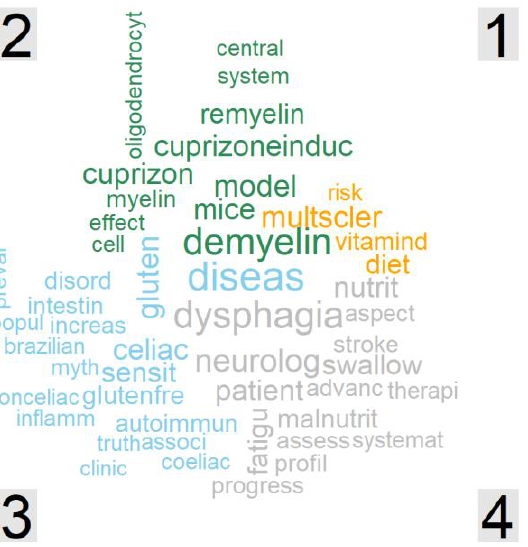
Figure 3. Comparison cloud of cluster 1, 2, 3 and 4. Orange, cluster 1; green, cluster 2; blue, cluster 3; and grey, cluster 4.